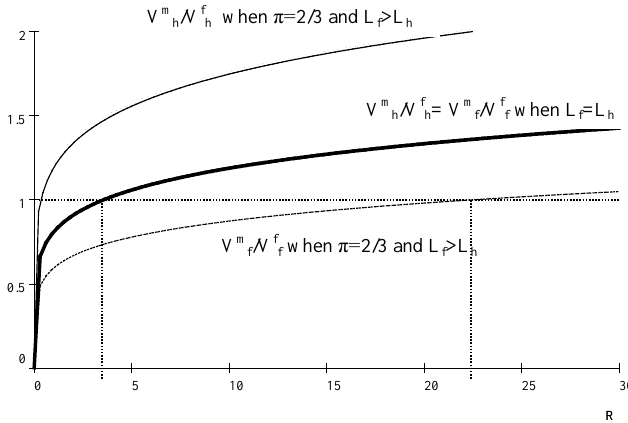
Figure 2. Relative indirect utility of market integration as a function of resources R. The figure shows simulations of Equations (17) and (18) at different parameter values. The thick line in the middle shows the indirect utility functions V m assumed parameter values are α f = β h = γ = δ = 2/3; α h = β f = 1/3; η = π = 1/2; L f = L h = 3. The dotted concave line on top and the thin concave line on the bottom show relative indirect utilities for herders and farmers, respectively, using the same parameter values as above with the only change being that we assume unequal levels of population and political power: π = 2/3; L f = 4, L h =